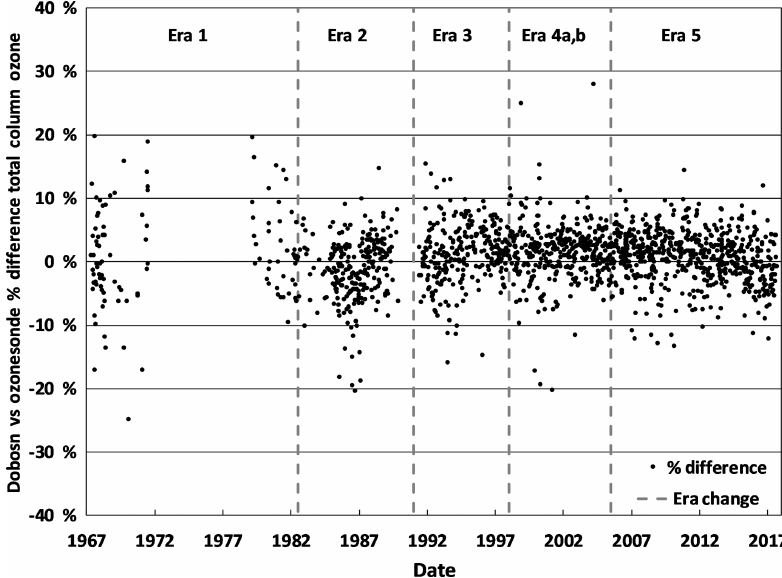
Figure 9. Boulder Dobson vs. ozonesonde total column ozone comparison.